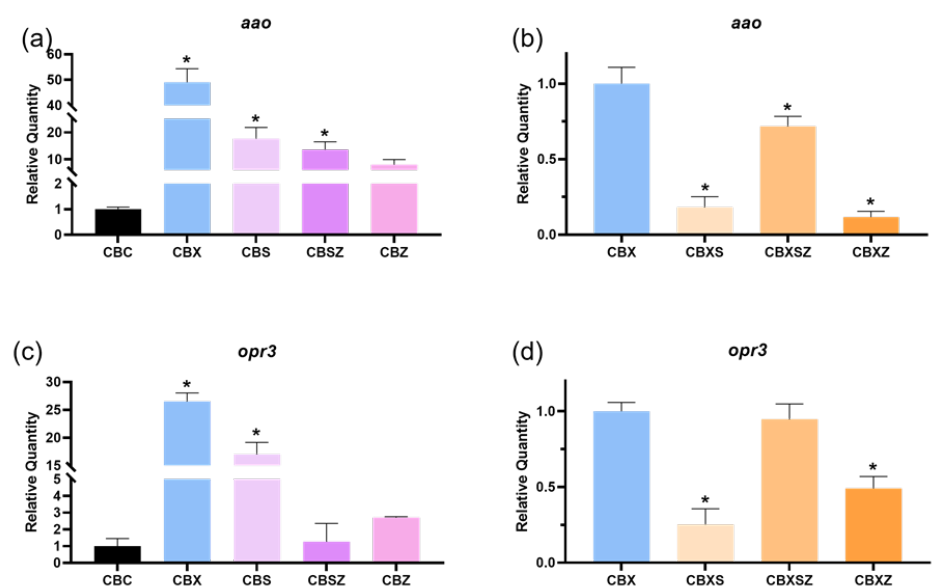
Figure 9. Relative expression levels of ABA and JA related pathways, aao ( a , b ) and opr3 ( c , d ) respec- tively, 10 days after treatments. Expression levels were determined through q-PCR. ( a , c )represent the uninfected/treated groups (CBS; CBSZ; CBZ) and the infected/untreated group (CBX) normalized to the negative control (CBC). While ( c , d ) stand for the infected/treated groups (CBXS; CBXSZ; CBXZ) compared with the positive control (CBX). Values are presented as mean ± standard deviation (n = 3). All values marked with “*” are statistically different from the control, according to the Dunnett comparison test ( p < 0.05).